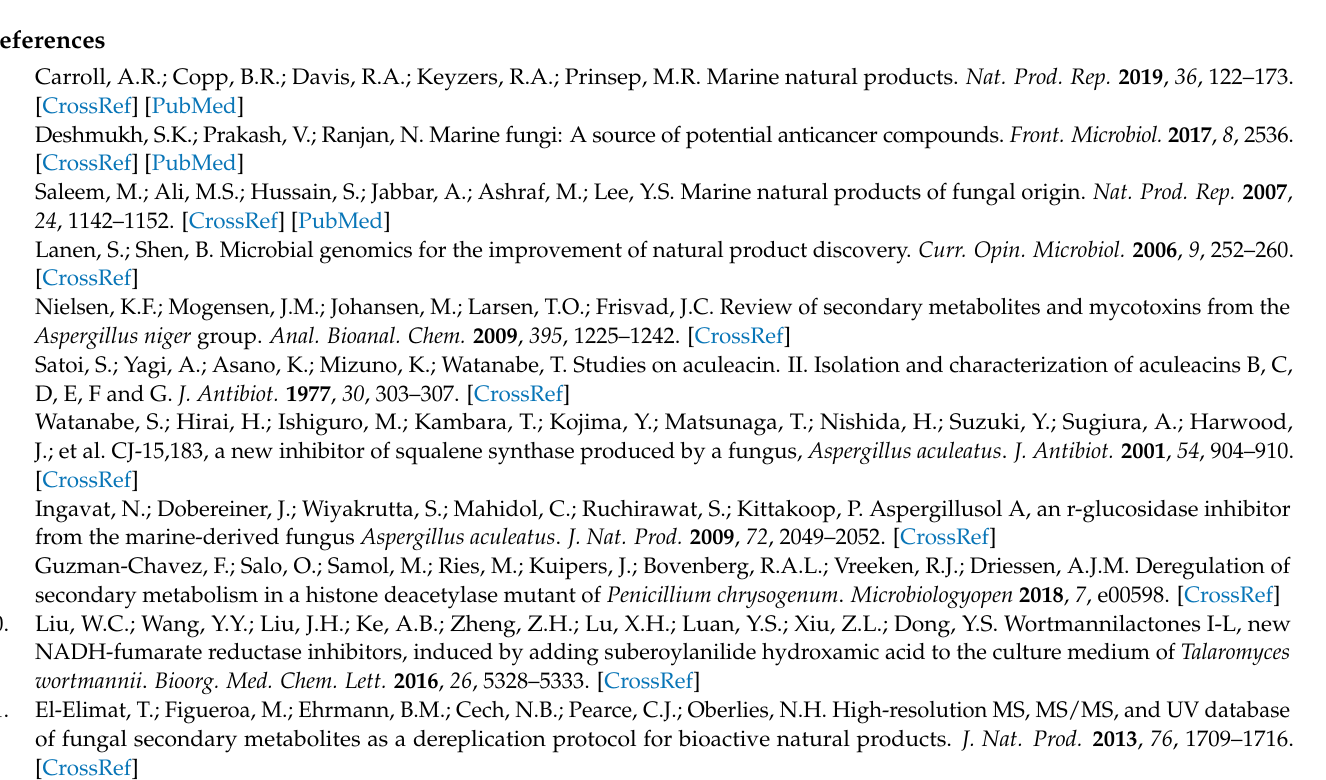
Figure S4: Annotated MS/MS spectrum; Figure S5: Positive HRESIMS spectrum of S5; Figure S6: 1 H NMR (500 MHz, DMSO- d 6 ) spectrum of pyranonigrin G ( S5 ); Figure S7: 13 C NMR (250 MHz, DMSO- d 6 ) spectra of pyranonigrin G ( S5 ); Figure S8: H-H COSY spectrum of pyranonigrin G ( S5 ); Figure S9: HMQC spectrum of pyranonigrin G ( S5 ); Figure S10: HMBC spectrum of pyranonigrin G ( S5 ); Figure S11: Calculated and experimental ECD spectra of pyranonigrin G ( S5 ); Figure S12: